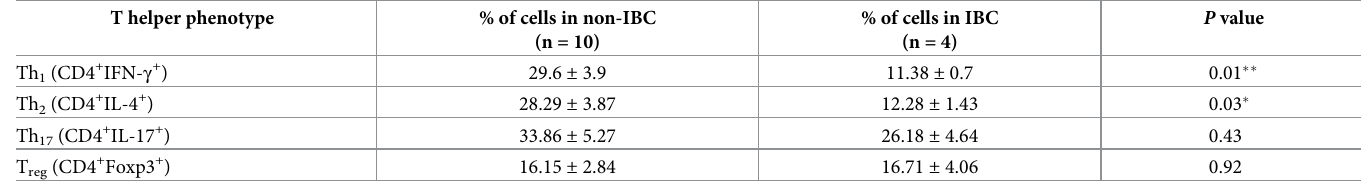
Values represent mean percentage ± SEM. n = number of